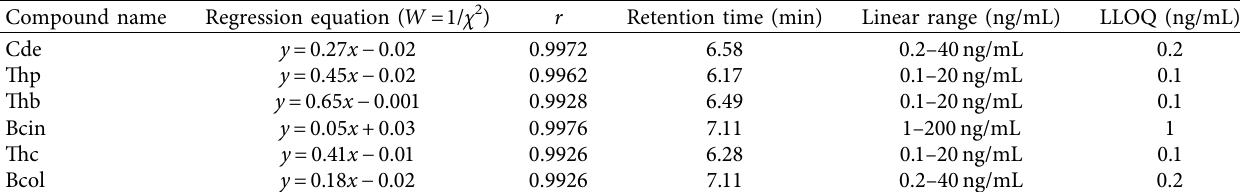
Table 4: The regression equation, retention time, linear ranges, and LLOQs of the six analytes in dog